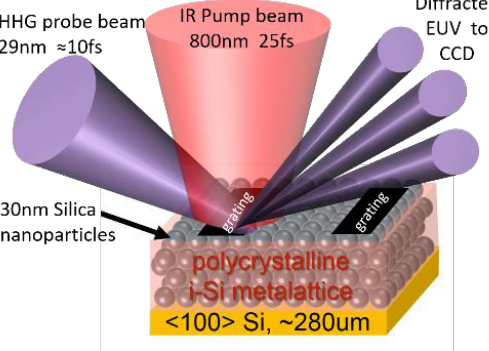
Fig. 1. EUV nanometrology of a silicon metalattice with silica spheres of 14 – 30nm. An IR laser excites the sample, and an ultrafast HHG beam then probes the thermal and acoustic